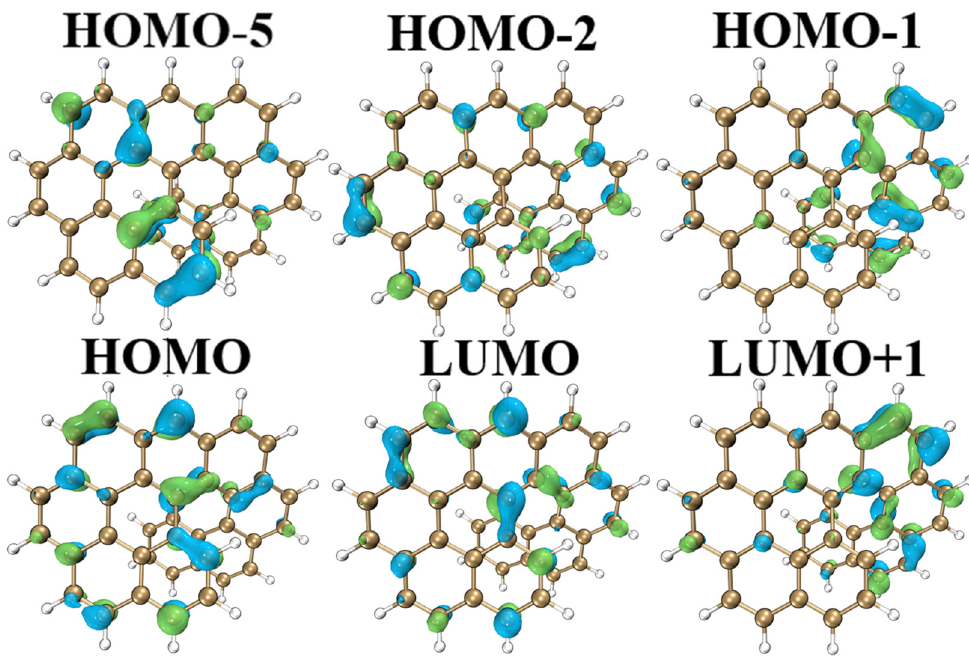
Figure 3. Schematic diagram of the molecular orbital of O9H. For such close structures, they have similar energies and roughly the same number of states. In the energy level range, the overall density of states is dominated by the P z orbitals, which allows more electrons to remain in the P z orbitals and be spin-polarized, which in turn enhances the local spin-polarization. The DOS between the two spikes flanking the Fermi level of O9H in the six figures is not zero and is broad. It shows that the covalent bond of the system is relatively strong at this time, and that the smaller the electronegativity, the greater the polarization. As shown in Figure 4, in the energy level range from approximately − 21.7 to − 5.3 eV, the total density of states is dominated jointly by P x , P y , and P z orbitals. In the energy level range from around − 21 to − 10 eV, the total density of states is dominated by P x , P y , and P z orbitals; whereas, in the energy level range from around − 10 to 5.5 eV, the total density of states is mainly dominated by the P z orbital [41], which indicates that the orbital polarization is caused by the P z